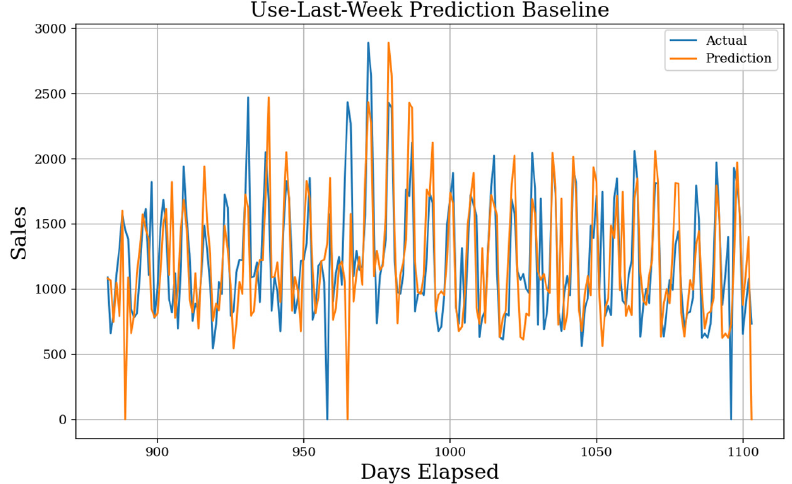
Figure 10. Use-Last-Week Prediction. Using the weekly seasonality, the next prediction baseline expects day D (t) is exactly the previous weekday D (t − 7). The MAE baseline generated is 278, and the prediction shape fails when experiencing extreme values.